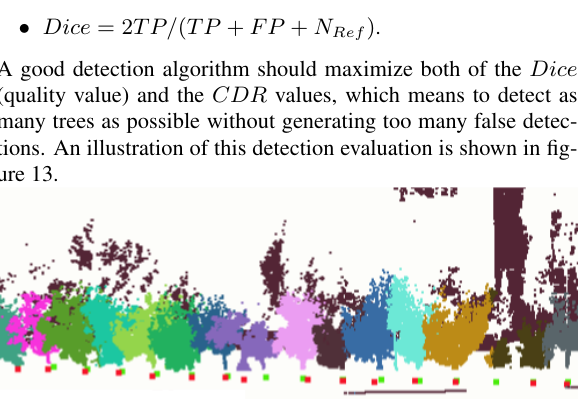
Figure 13: Centres of the trunks detected by our algorithm (red) and trunk centres from the reference database (green).